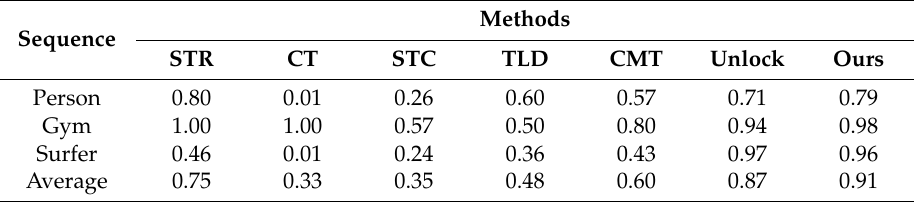
Table 1. Recall rate comparison with state-of-art methods of tracking.